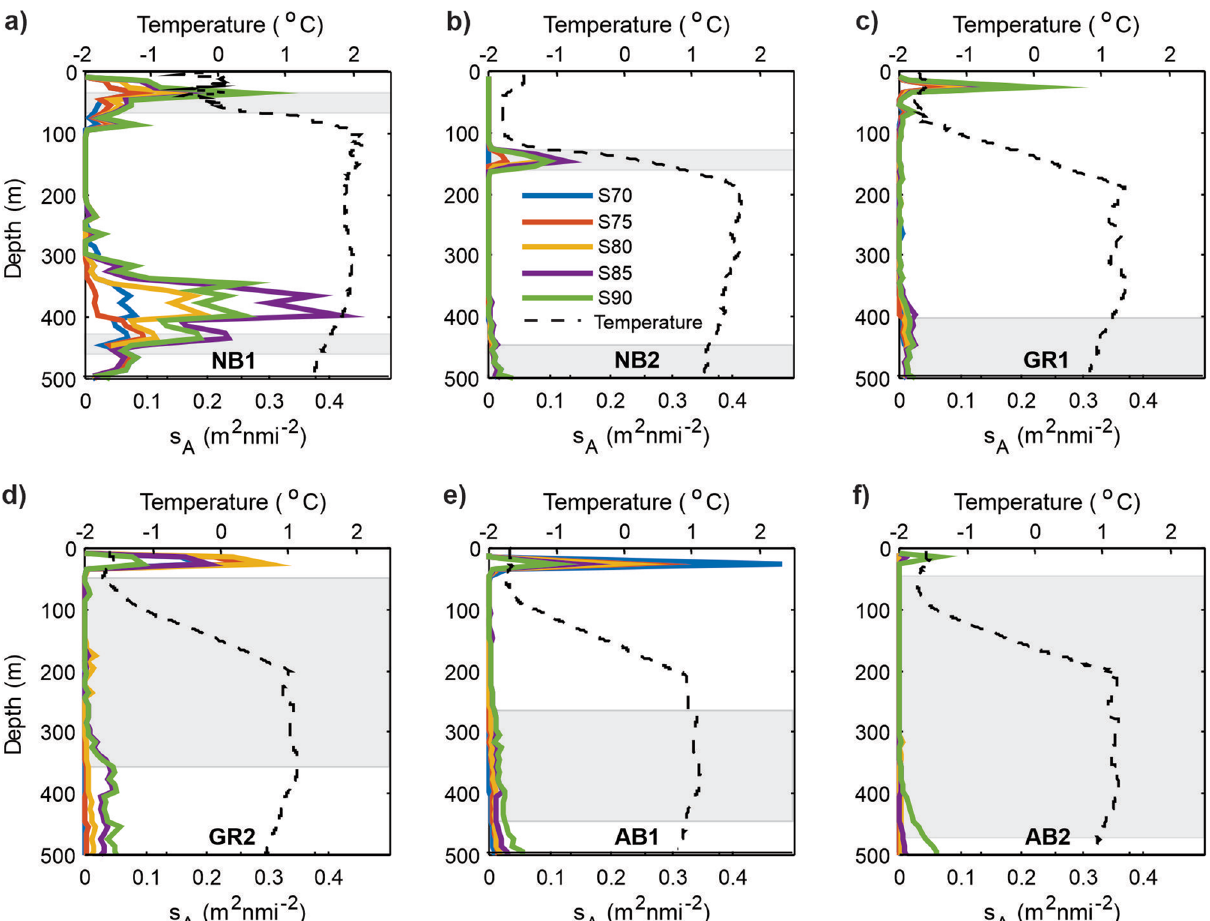
Figure 4. Acoustic backscatter in the Eurasian Basin. Profiles of acoustic backscatter from six locations in September 2021 ( a-f ). The various categories of scatterers are coded with colours. ---- show the temperature from the nearest CTD station, while ▬ are the depth intervals where the trawls were conducted (Harstad or macroplankton or both). Note that a single strong echo, observed at about 265 m depth at NB1 (Fig. S18) was excluded when plotting this